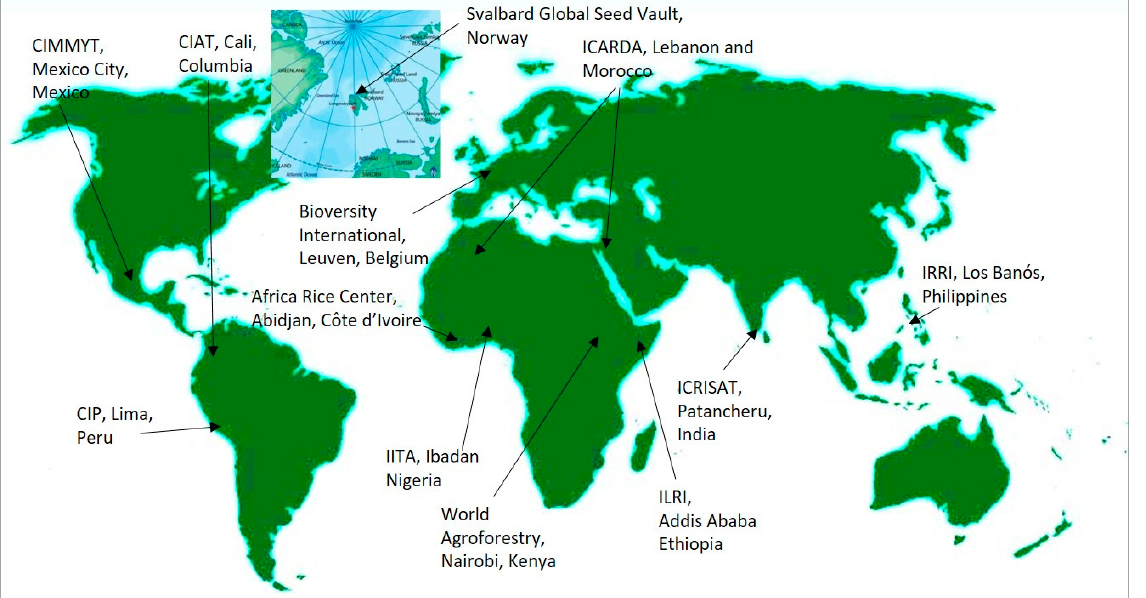
Figure 7. The location of the major international crop genebanks under the Consortium of Interna- tional Agricultural Research Centres (CGIAR) network. CIMMYT—International Wheat and Maize